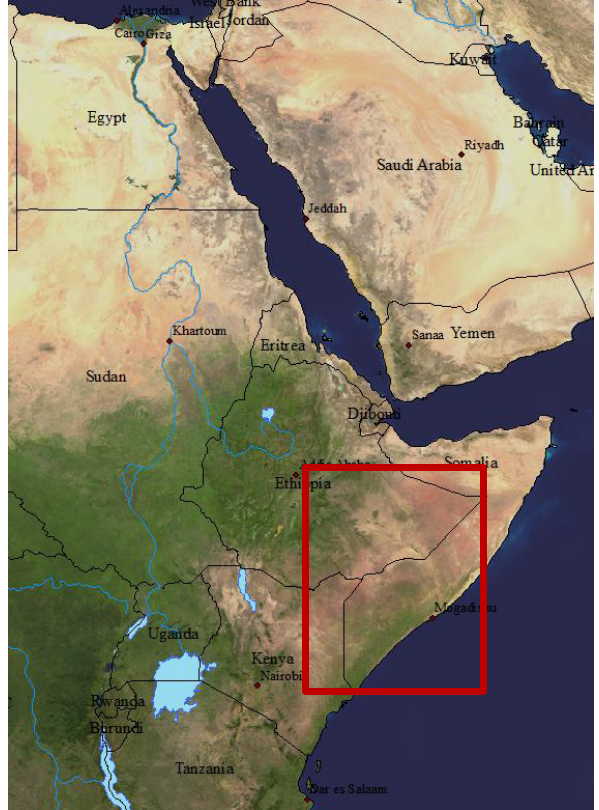
Fig. 1. Selected area of interest within the Horn of Africa